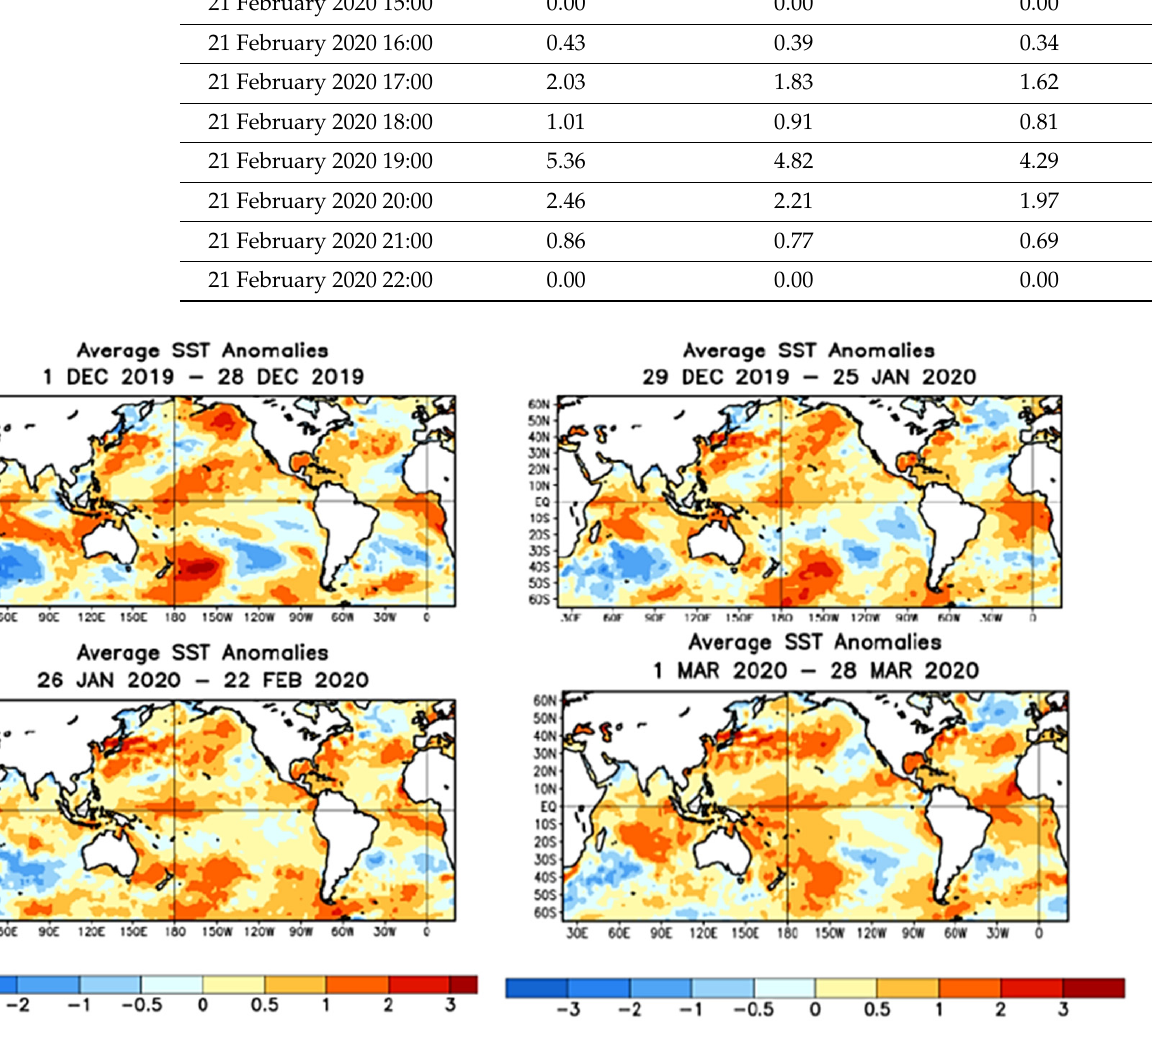
Table 8. SOCONT model parameters for each sub-basin. Sub-Basins